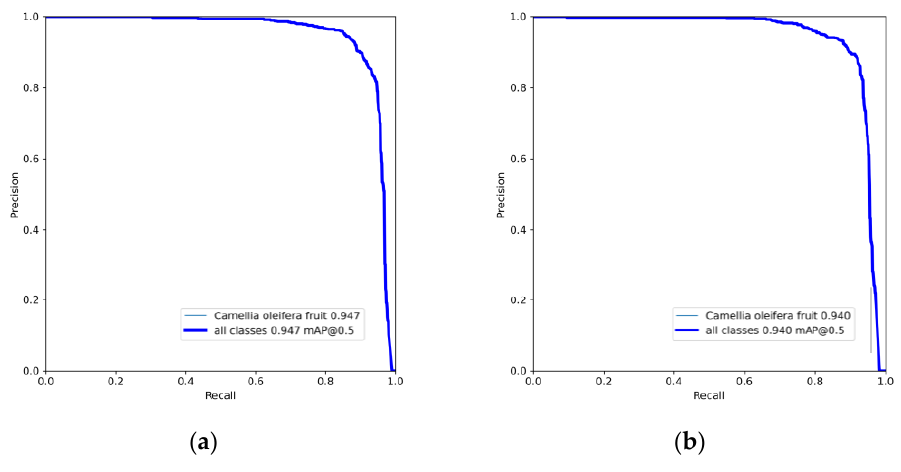
11 of 16 Figure 9. Loss function value curve.